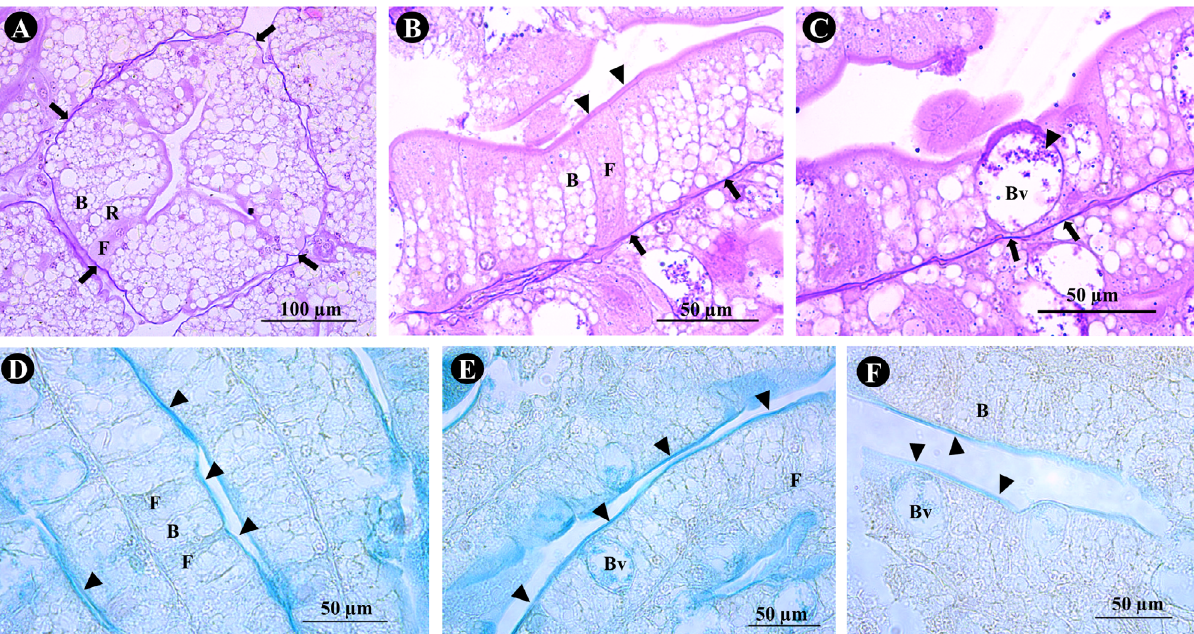
Figure 3. Histochemistry of the hepatopancreatic tubules of Macrobrachium carcinus . ( A ) Transverse section showing basement membrane region continues (arrows) around the tubule and R-, F-cells and B-cells with small vacuoles. ( B ) Middle region epithelium showing brush border region (arrowheads) evident on B- and F-cells. ( C ) Detail of B-cell with PAS-positive corpuscles within the large vacuole (arrowhead). ( D, E ) Histochemistry of AB 2.5 showing a moderate reaction on the brush border region (arrowhead). ( F ) Histochemistry of AB 1.0 showing a positive reaction on the brush border region (arrowhead). Abbreviations: B: B-cells; Bv: B-cells with a large vacuole; F: F-cells; R: R-cells. Reactions: PAS ( A, B, C ); AB 2.5 ( D, E ); AB 1.0 ( F